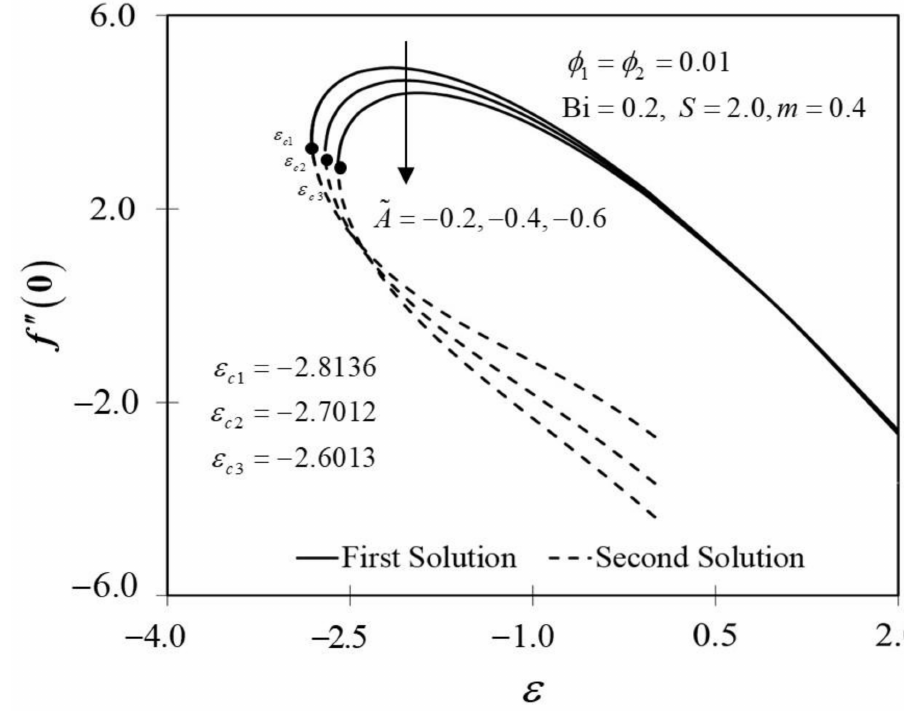
Figure 8. Trend of f (cid:48)(cid:48) ( 0 ) with ε and assorted A .